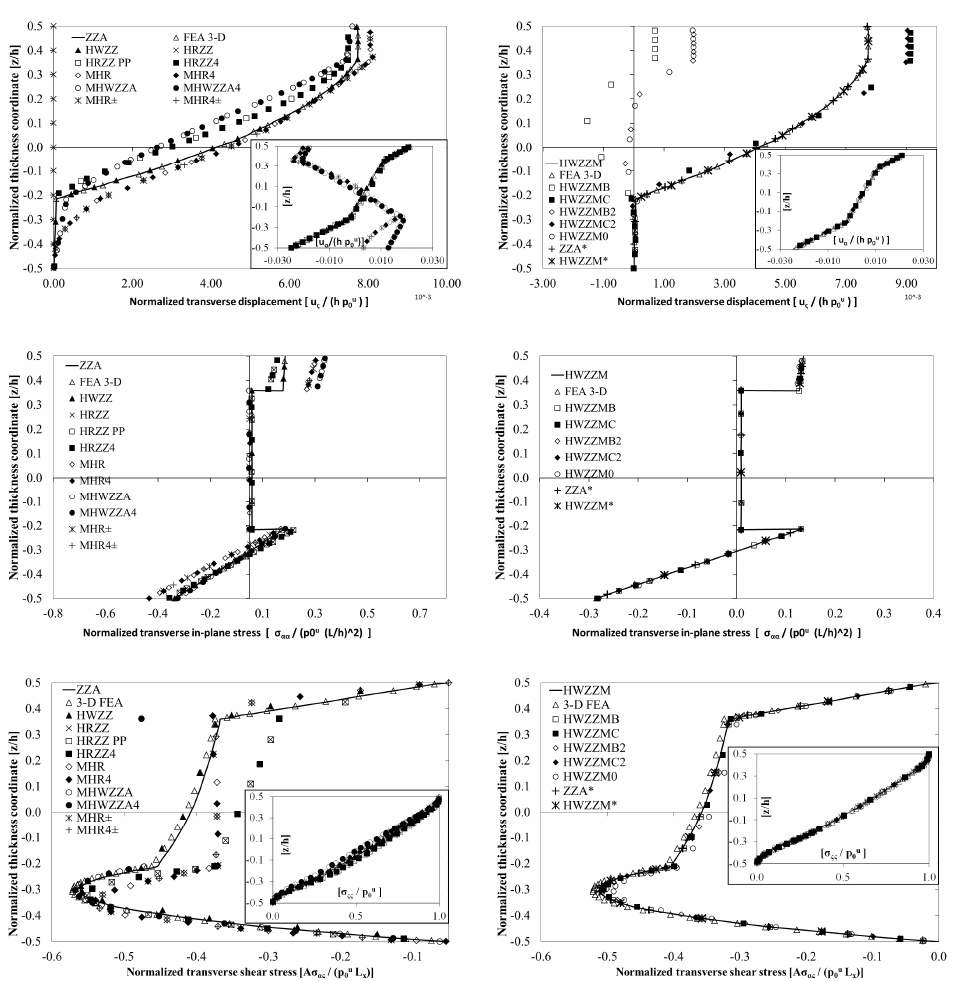
Figure 2. Case a2: Propped cantilever sandwich plate in cylindrical bending ( Lx / h = 20) under a uniform loading on the top layer.